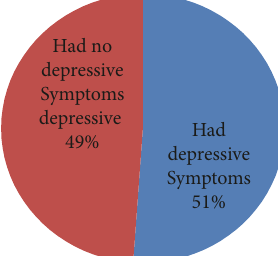
Figure 1: Prevalence of depression among adults with HF attending cardiac follow-up clinics inWestAmhara Region Referral Hospitals, Northwest Ethiopia, 30 March to 15 May 2017 G.C